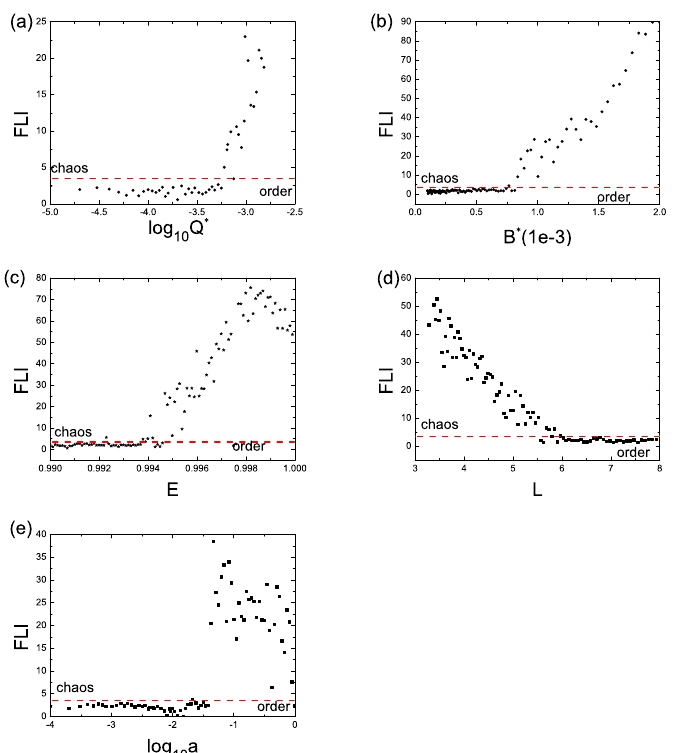
Figure 11. Dependence of FLIs on the parameters. Each of the FLIs is obtained after the integration time w = 10 6 . The parameters and initial separations are as follows. ( a ) E = 0.9935, L = 4.6, a = 0.5, B ∗ = 0.001, and r = 100. ( b ) E = 0.995, L = 4.6, a = 0.5, Q ∗ = 0.0001, and r = 75. ( c ) L = 4.6, a = 0.5, B ∗ = 1 × 10 − 3 , Q ∗ = 1.25 × 10 − 4 , and r = 75. ( d ) E = 0.995, a = 0.5, B ∗ = 1 × 10 − 3 , Q ∗ = 1.25 × 10 − 4 , and r = 75. ( e ) E = 0.995, L = 4.6, B ∗ = 1 × 10 − 3 , Q ∗ = 2 × 10 − 7 , and r =